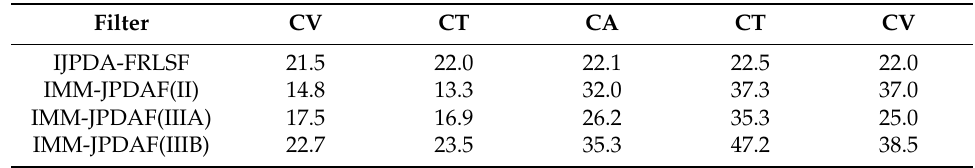
Table 2. The average root-mean-square (RMS) position error for Target I (unit: m). Improved